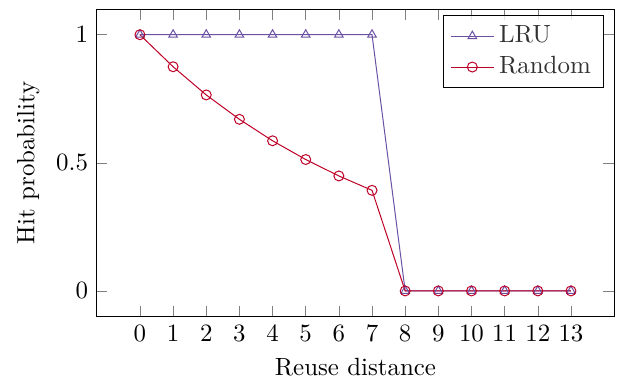
Figure 1 Lower bounds on hit probabilities of memory accesses for LRU and Random in terms of reuse distances for a cache of associativity 8 based on Equations 1 and